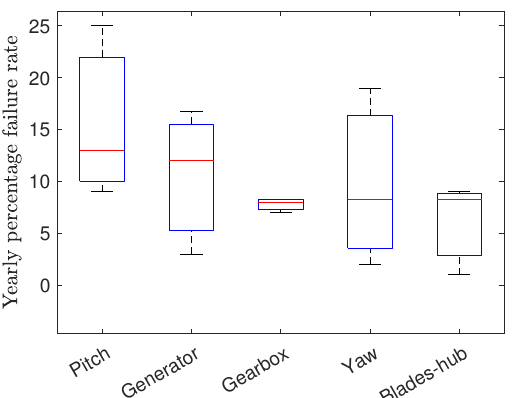
Figure 10. Box plot of components with higher failure rates for HAWT offshore wind farms. Data from Dinwoodie and McMillan, Carroll et al. and Dao et al. [45,76,77].